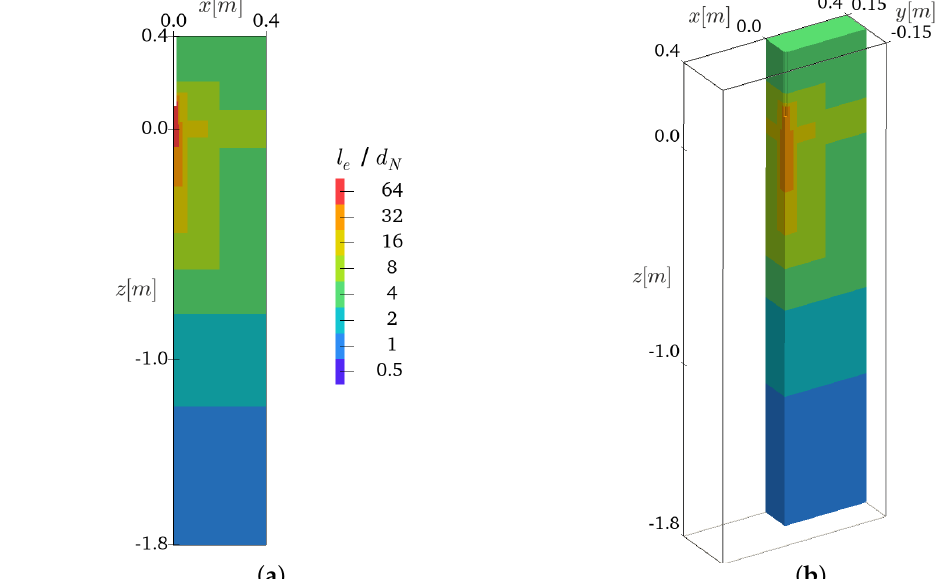
Figure 1. Impinging jet—mesh 2D and 3D average edge length ( l e ): ( a ) W64. ( b ) CS32 ( x > 0 and y >